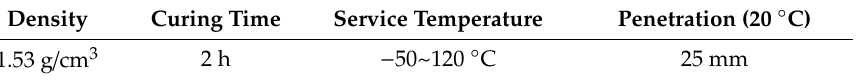
Table 1. Material properties of the asphalt.